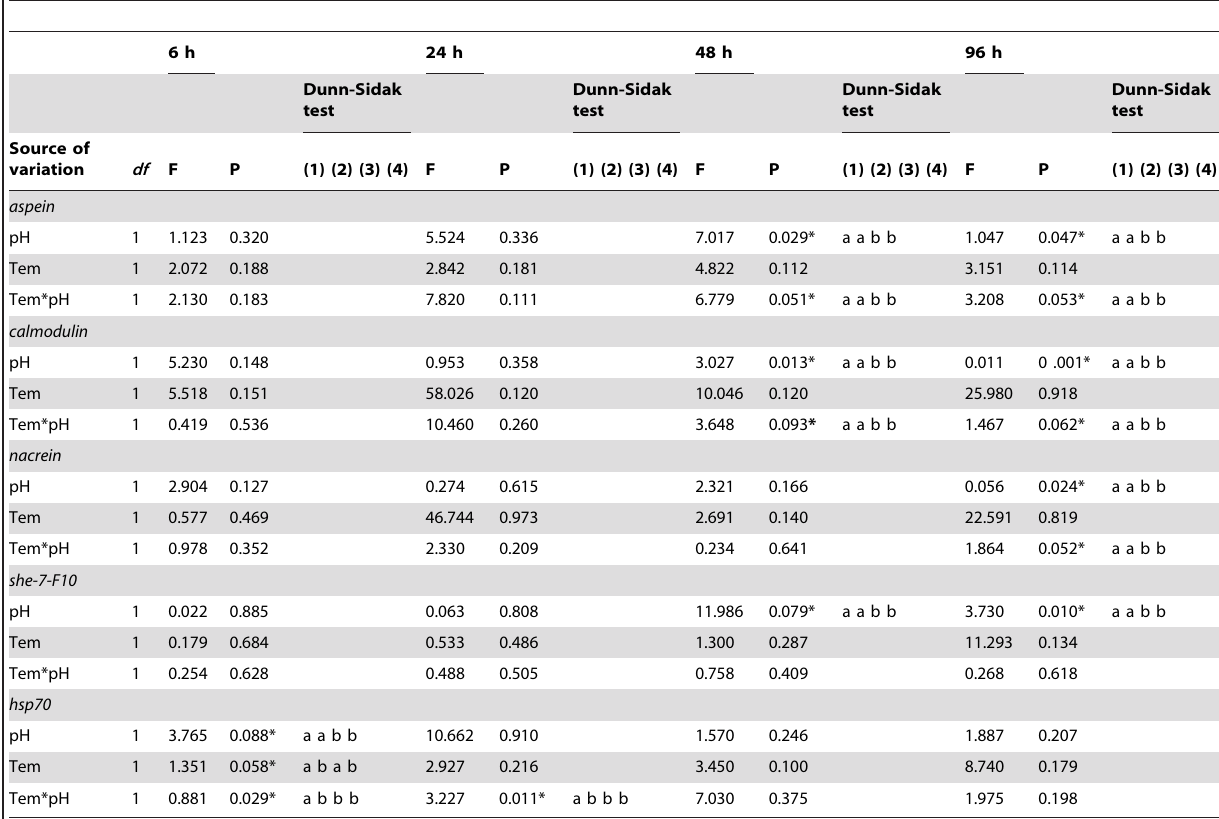
Table 3. Results of statistical tests performed to test the effects of pH and temperature on gene expression patterns of aspein , calmodulin , nacrein , she-7-F10 and hsp70 in Pinctada fucata .